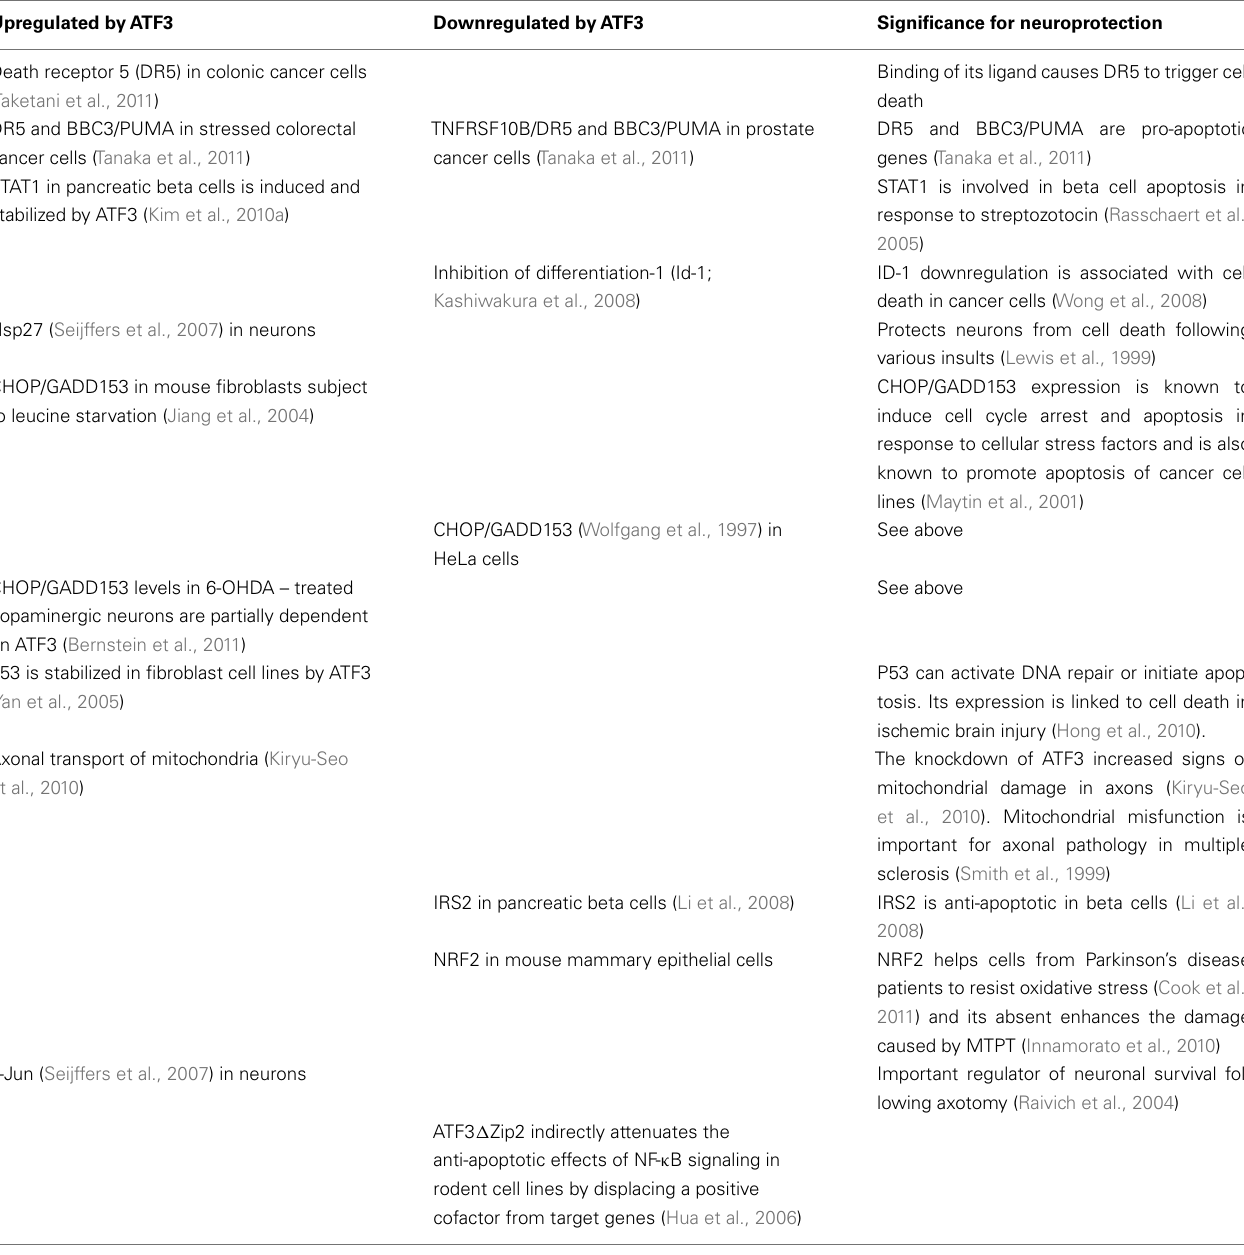
Table 2 | Genes and signaling pathways regulated byATF3 that are potentially related to neuronal death/neuroprotection. Upregulated